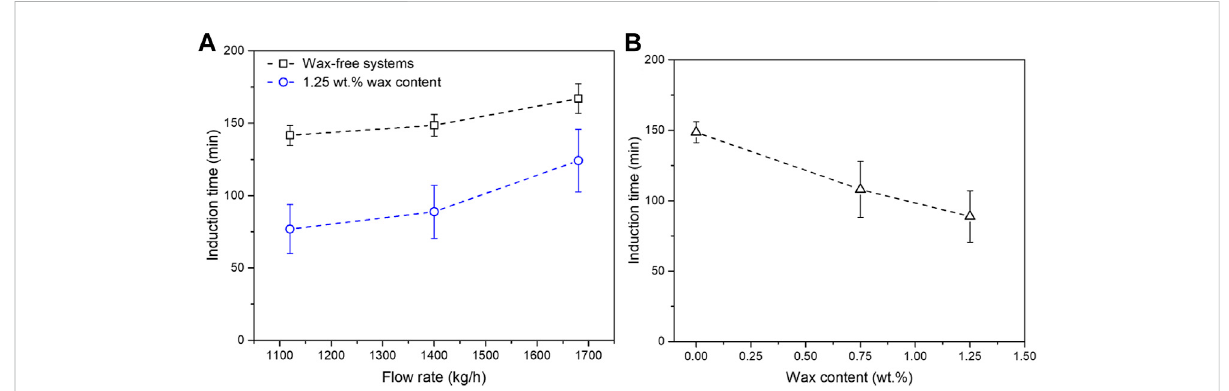
FIGURE 3 (A) Induction time of wax-free systems (cases 1~3) and 1.25 wt% wax content systems (cases 5~7) under different initial fl ow rates. Induction time is an averaged value of repeated experiments. The error bar refers to the standard deviation. (B) Induction times of different wax-content systems with the same experimental condition (cases 2, 4, and